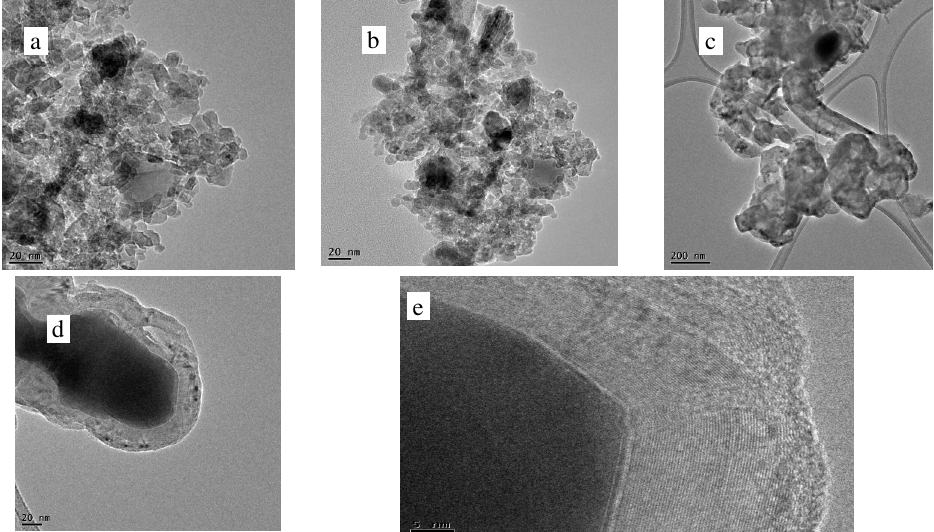
Figure 4. TEM image of carbon nanotube prepared from Co/Zn/Al (a and b) and Fe/Ni/Al (c, d and e) catalysts. Figure 4(e) is a higher magnification of Figure